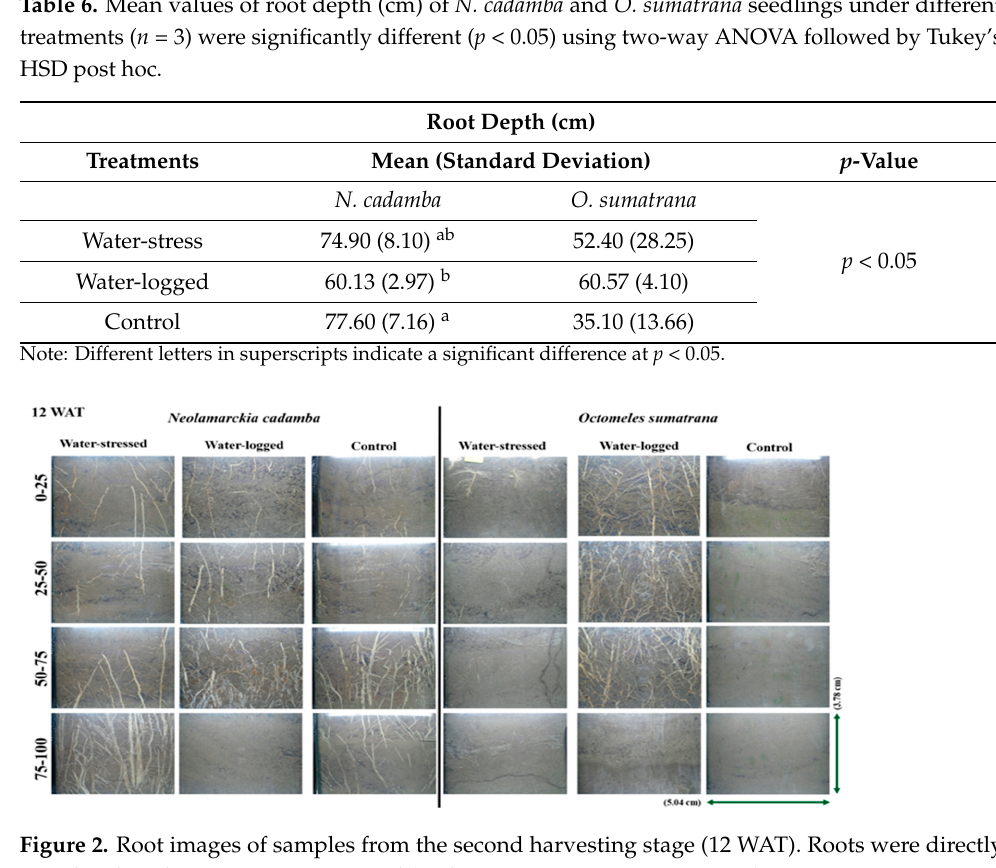
Table 5. Mean values of dried shoot biomass (g) of N. cadamba and O. sumatrana seedlings under different treatments ( n = 3) were not significantly different ( p > 0.05) using two-way ANOVA fol- lowed by Tukey’s HSD post hoc.